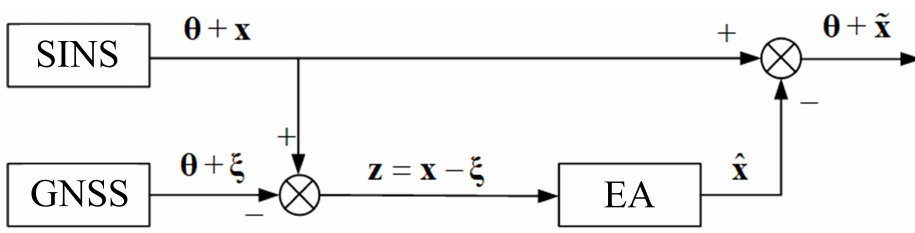
Figure 2. The correction scheme of SINS errors using the estimation algorithm (EA). θ is the true information about the navigation parameters of the aircraft. x is the state vector consisting of the SINS errors. ξ is the GNSS measurement errors. z is the measurement vector, which is a mixture of SINS and GNSS errors. ˆ x is the state estimate of the SINS errors. ˜ x is the estimation